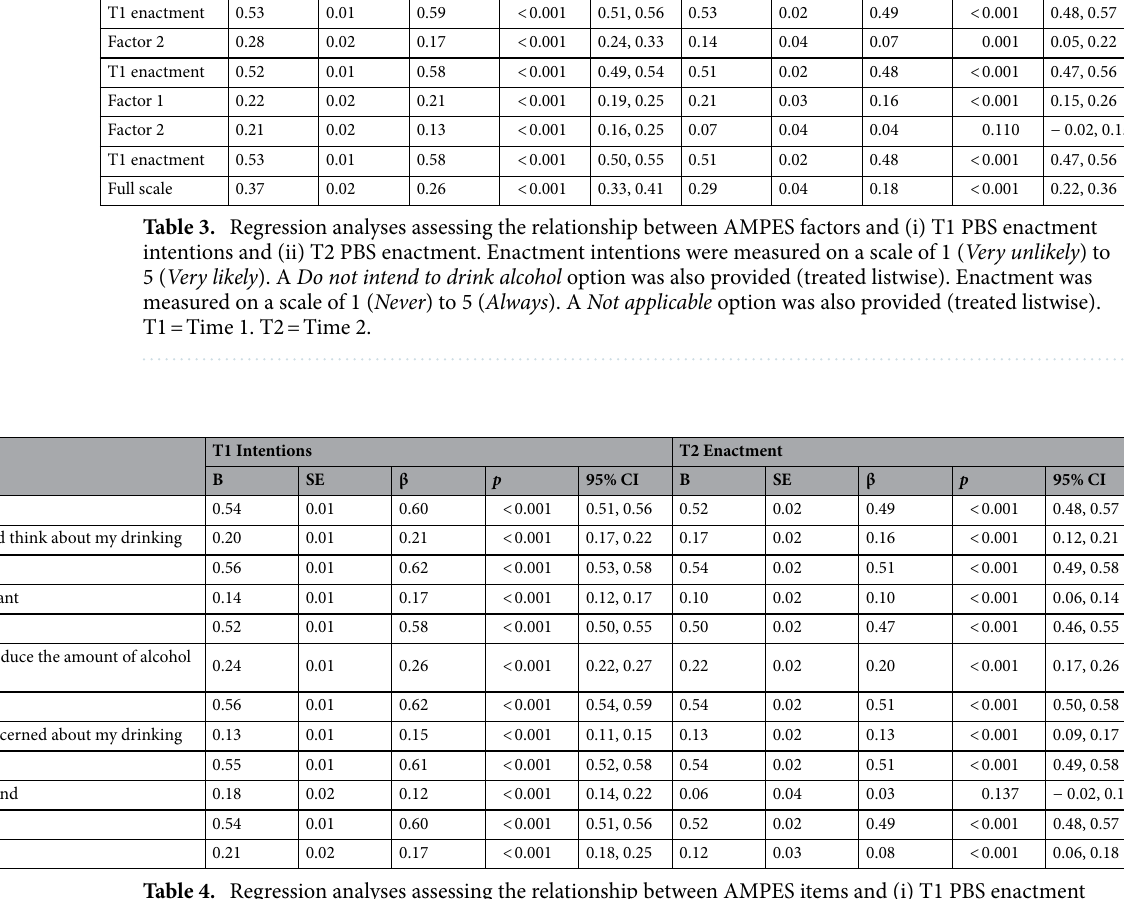
Table 4. Regression analyses assessing the relationship between AMPES items and (i) T1 PBS enactment intentions and (ii) T2 PBS enactment. Enactment intentions were measured on a scale of 1 ( Very unlikely ) to 5 ( Very likely ). A Do not intend to drink alcohol option was also provided (treated listwise). Enactment was measured on a scale of 1 ( Never ) to 5 ( Always ). A Not applicable option was also provided (treated listwise). T1 = Time 1. T2 = Time